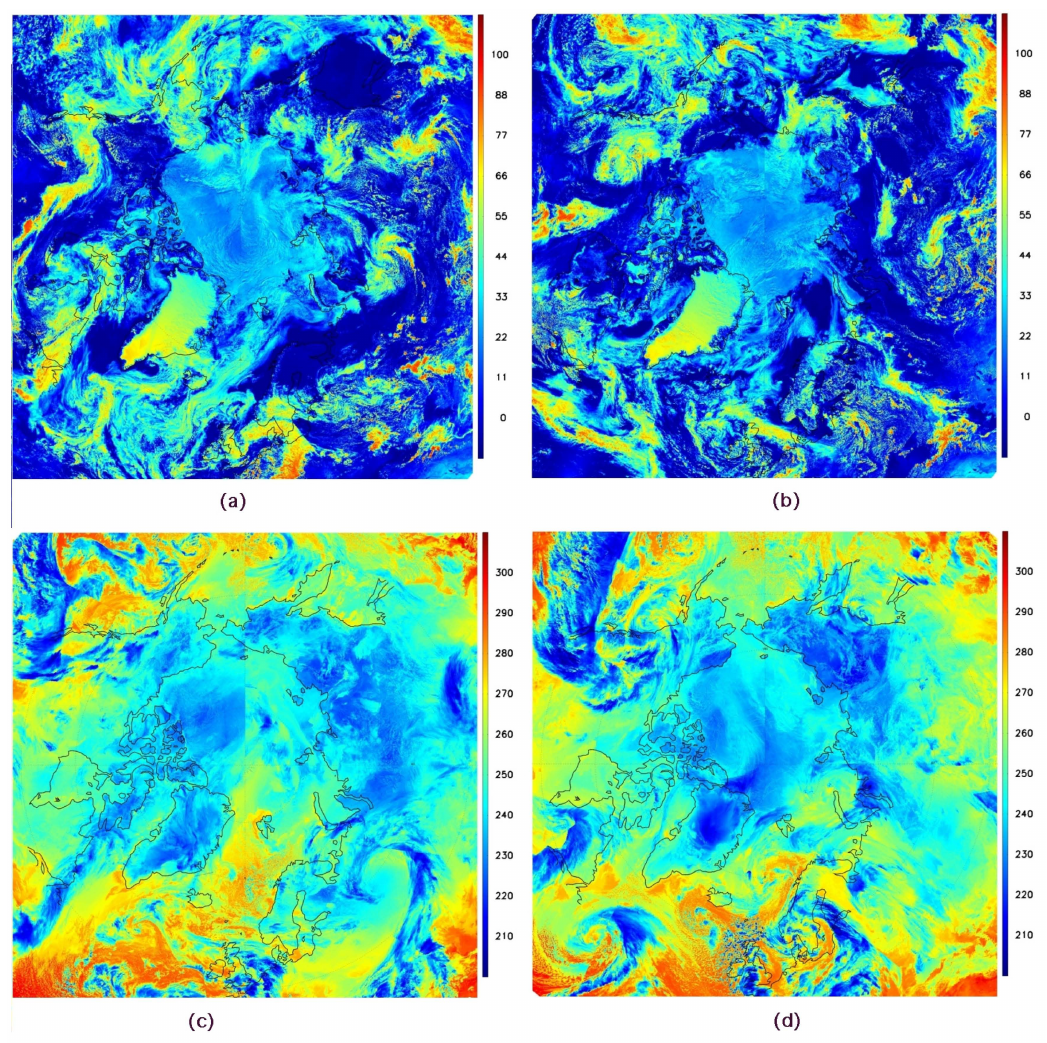
Figure 4. The APP product for the dates and channels corresponding to the MODIS composites in Figure 3. Top: APP channel 1 reflectance over the Arctic on day 182 of 2003 ( a ), and on day 182 of 2007 ( b ) at 14:00 local solar time (LST). Bottom: APP channel 4 brightness temperature on day 1 of 2003 ( c ), and on day 1 of 2007 ( d ) at 14:00